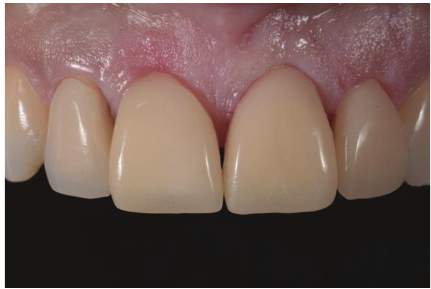
Figure 7: Double cord retraction technique.